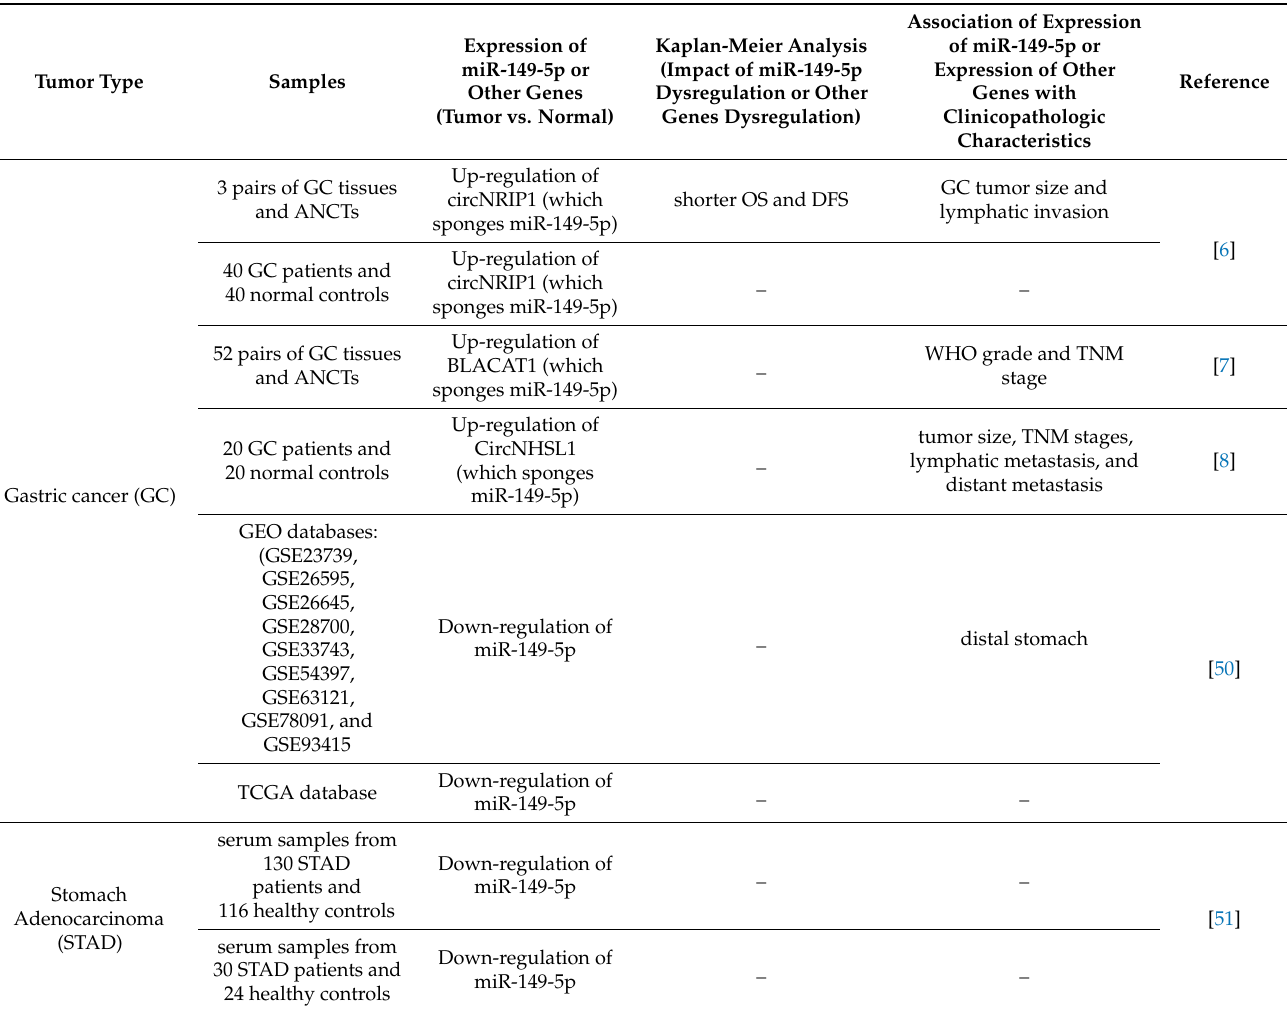
Table 3. Role of miR-149-5p or miR-149-5p-interacting genes in carcinogenesis based on clinical studies (OS: Overall survival, DFS: disease-free survival, PFS: progression-free rate TNM: tumor- node-metastasis, ANCTs: adjacent non-cancerous tissues, NSCLC: non-small cell lung cancer, ccRCC: clear cell renal cell